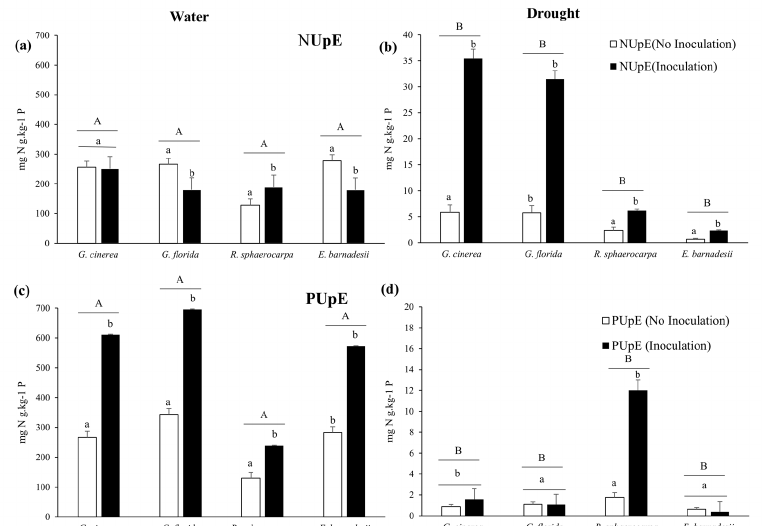
Figure 5. Nitrogen and phosphorus content in G. cinerea , G. florida , E. barnadesii and R. sphaerocarpa grown under six treatments of inoculation and P sources: control, inoculation, high Phosphorus, inoculation and high phosphorus, low Phosphorus, inoculation and low phosphorus in water condition and drought conditions. Values are presented as means ( n = 13–15) with standard error bars. Statistical analyses were performed independently for N and for P. Different letters on top of columns indicate significant differences for each nutrient across treatments (drought and water) using the post-hoc Fisher’s LSD, multiple range test ( p ≤ 0.05).